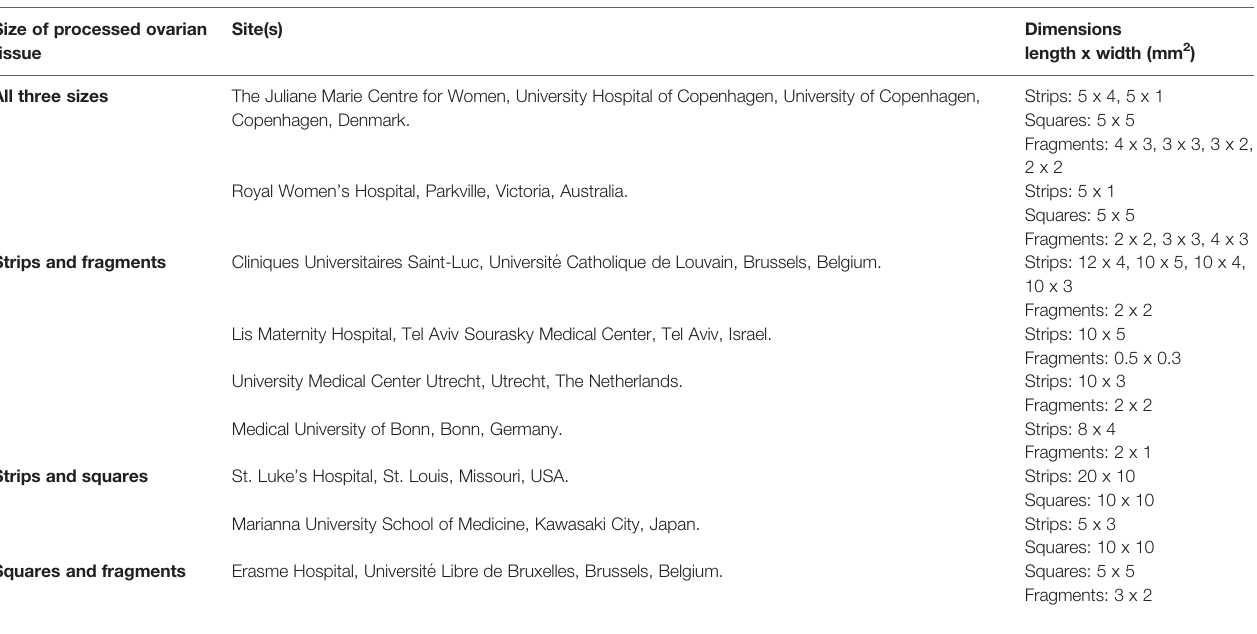
TABLE 2 | Processing sites that cut ovarian tissue into different